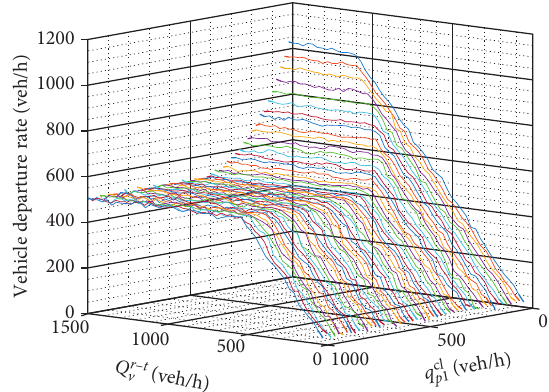
Figure 7: Relationship among C